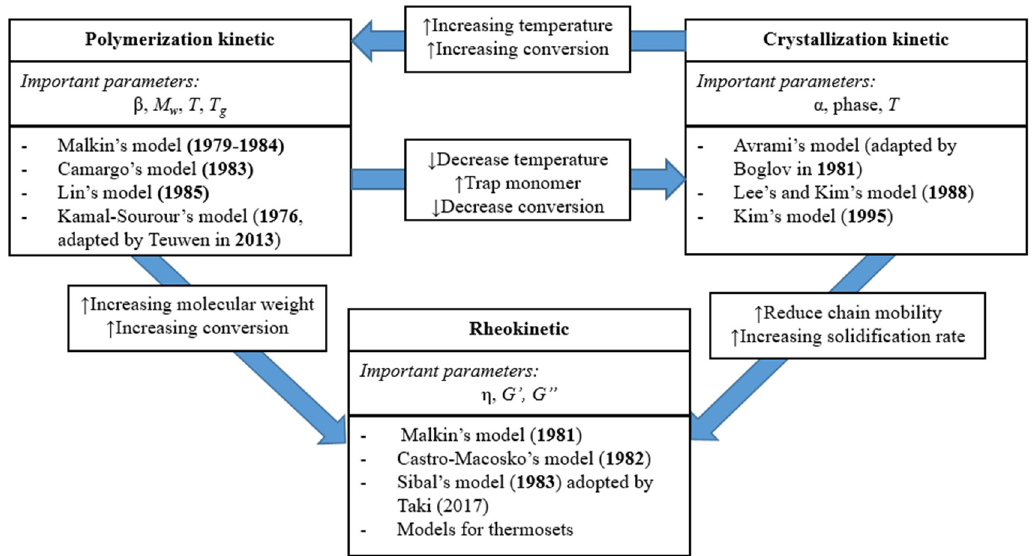
Figure 1. Interaction between polymerization, crystallization, and rheology in the anionic ring opening polymerization (AROP) of caprolactam ( α —degree of crystallinity, β —degree of conversion, M w —molecular weight of the polymer, T —processing temperature, T g —glass transition temperature